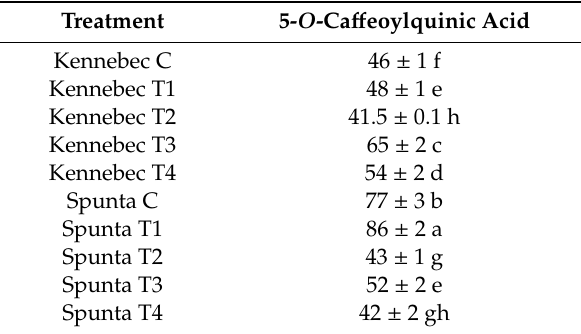
Standard calibration curves: 5- O -Ca ff eoylquinic acid (y = 168823x − 161172, R 2 = 0.999). 5- O -Ca ff eoylquinic acid (Rt: 7.0 min; λ max: 324 nm; [M-H] − m / z at 353; MS 2 : 191(100),179(50),161(23),135(10)). Means in the same column followed by di ff erent Latin letters are significantly di ff erent at p < 0.05 according to Tukey’s HSD.